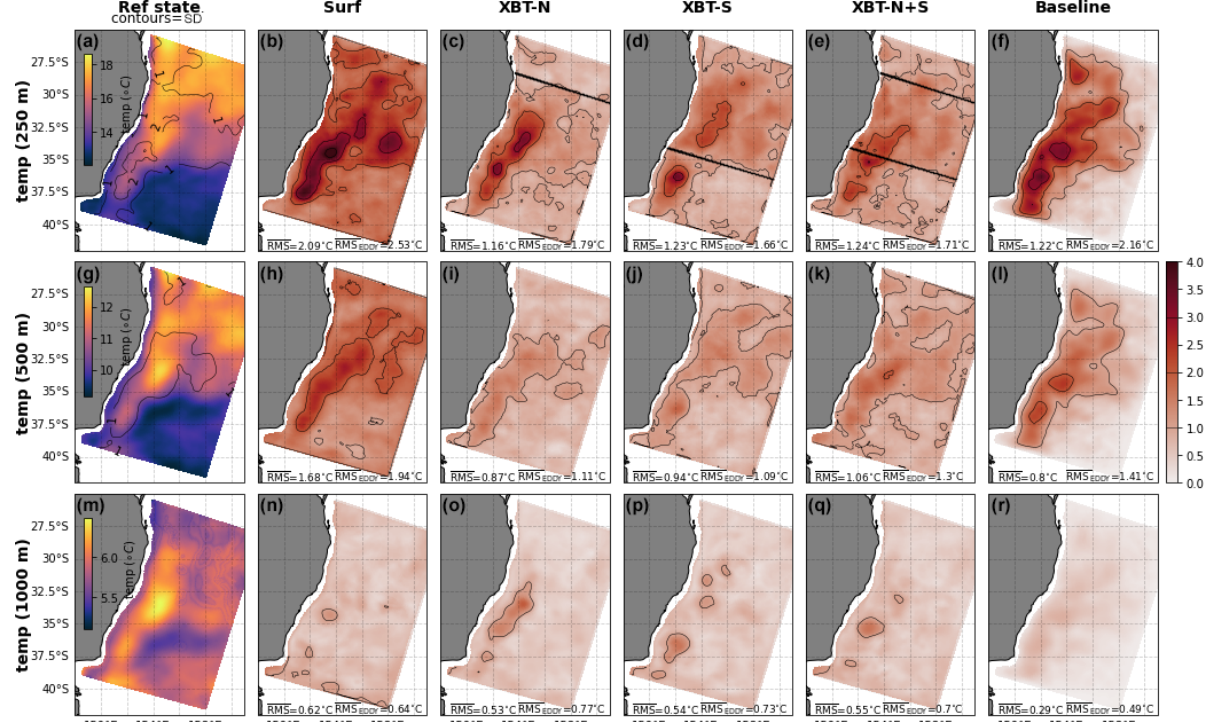
Figure 5. The differences in spatial representation of temperature between the reference state and each OSSE. (a) The mean temperature field at 250m in the reference state, with contours of standard deviation in that field. The rms error between the reference state and the OSSEs (b) surf, (c) XBT-N, (d) XBT-S, (e) XBT-N+S, and (f) the baseline simulation. The second row (panels g–l ) is the same, but at 500m, and the third row (panels m–r ) shows the same fields at 1000m. Note that colour scales are identical for all rms error plots. In reference state panels, contours are the standard deviation in the respective field while in all OSSE panels, the contours are of RMSE. Contour intervals are the same for all panels and are shown as a line in the RMSE colour bar. Black lines in panels (c–e) indicate location of the XBT lines. The area-mean RMSE and the mean RMSE over the high EKE region in box b (see Fig. 3b) are shown for each